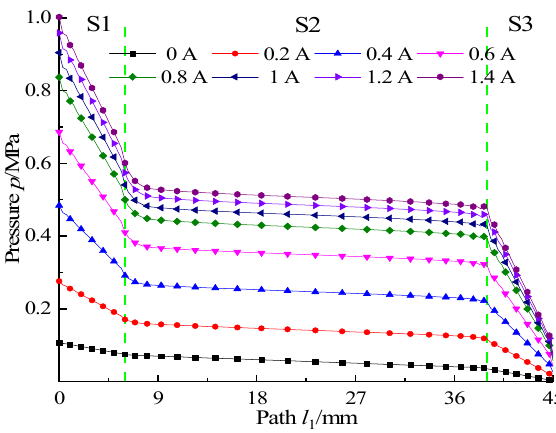
Figure 13. Pressure distribution along the path at different currents.